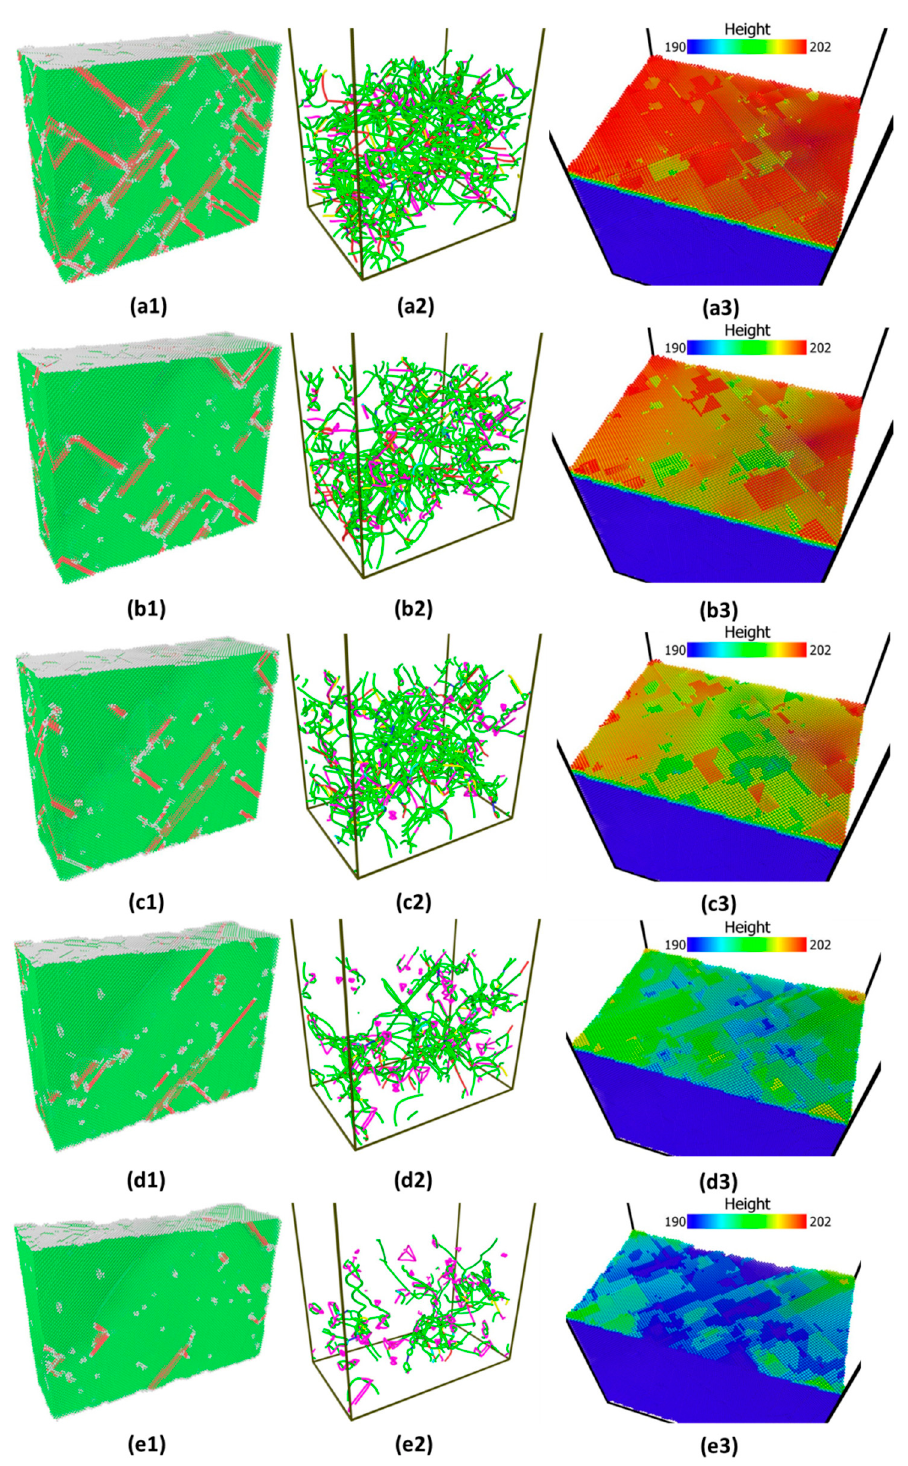
Figure 11. Snapshots of initial atomic structure, distributions of dislocations, and surface morphology before indentations at various strain levels ( a1 – a3 ) 0.14, ( b1 – b3 ) 0.15, ( c1 – c3 ) 0.2, ( d1 – d3 ) 0.3, and ( e1 – e3 ) 0.4.